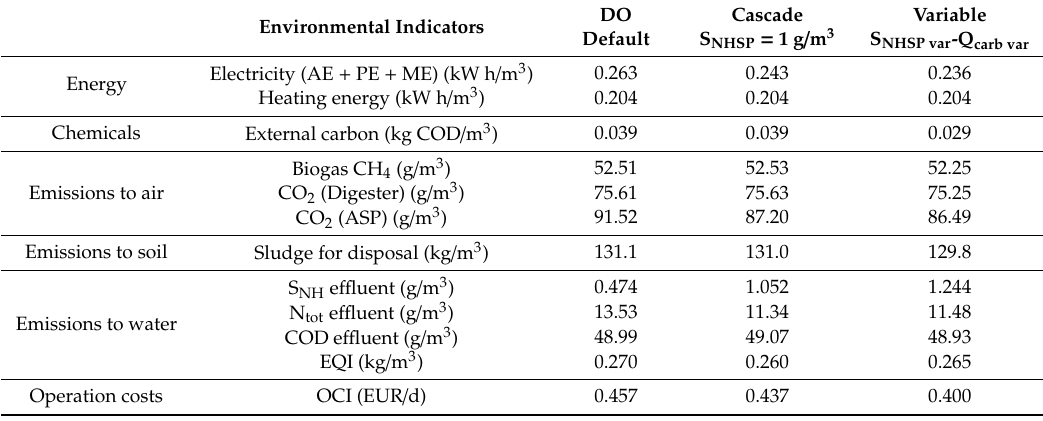
Table 13. Annual values of environmental indicators and operating costs of BSM2 plant with respect to the volume of treated wastewater with the Cascade S NHSP and proposed alternative strategies.